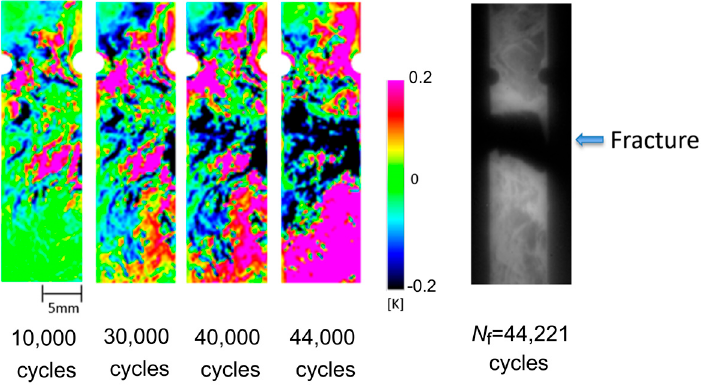
Figure 7. TDA images and infrared image obtained after specimen failure ( σ max = 180 MPa, f = 7